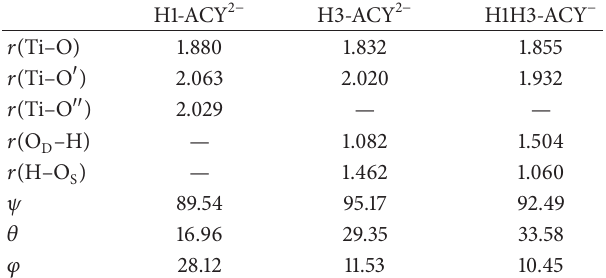
Table 5: Distances, in ˚A, and angles, in o , relevant to the binding primarily through the –OH group of the dye to the nanocluster. O refer to the distances between the H3 proton and the H and H–O S adjacent oxygen atom on the dye and on the substrate, respectively. The geometry was optimized at DFT/B3LYP/3-21G(d) level.